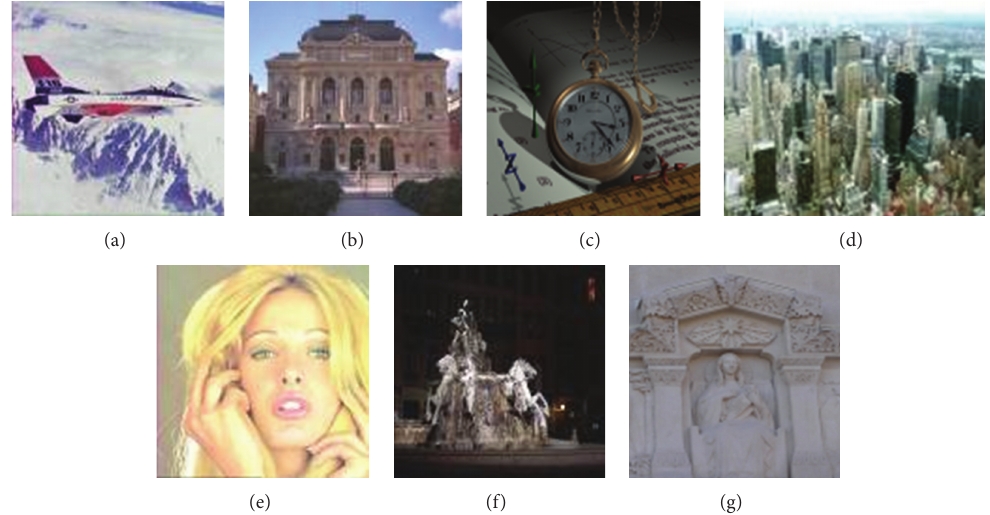
Figure 14: The other seven color images used for testing uniqueness.